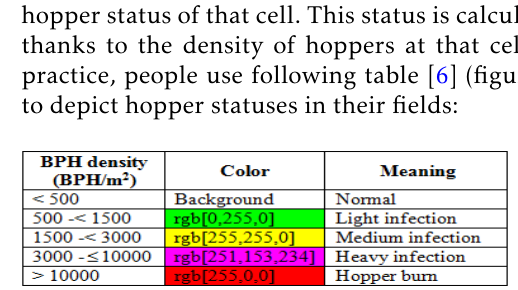
Figure 6. Ascendinglevels of infestedBPHs in rice fields